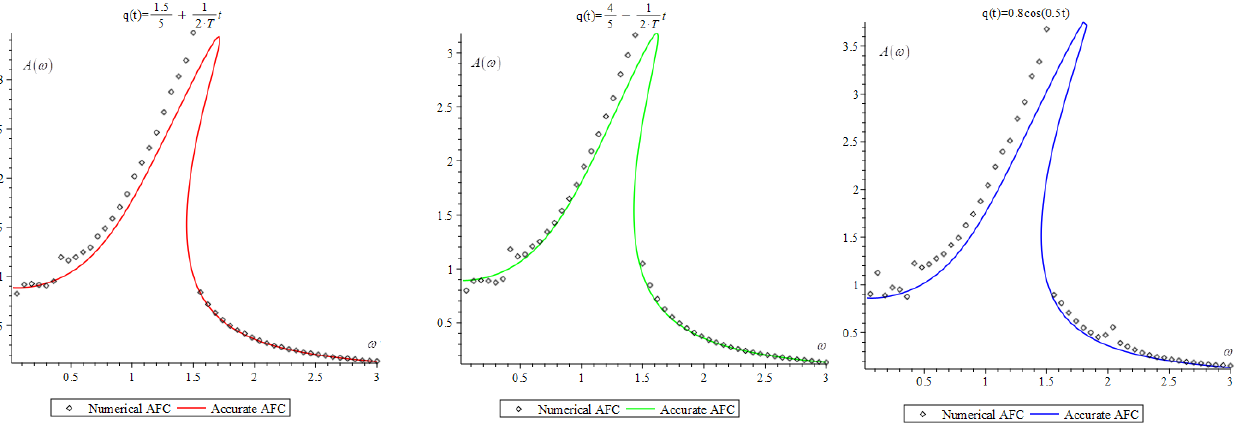
Figure 5. Amplitude–frequency characteristic of the fractional Duffing oscillator for various types of the q ( t )